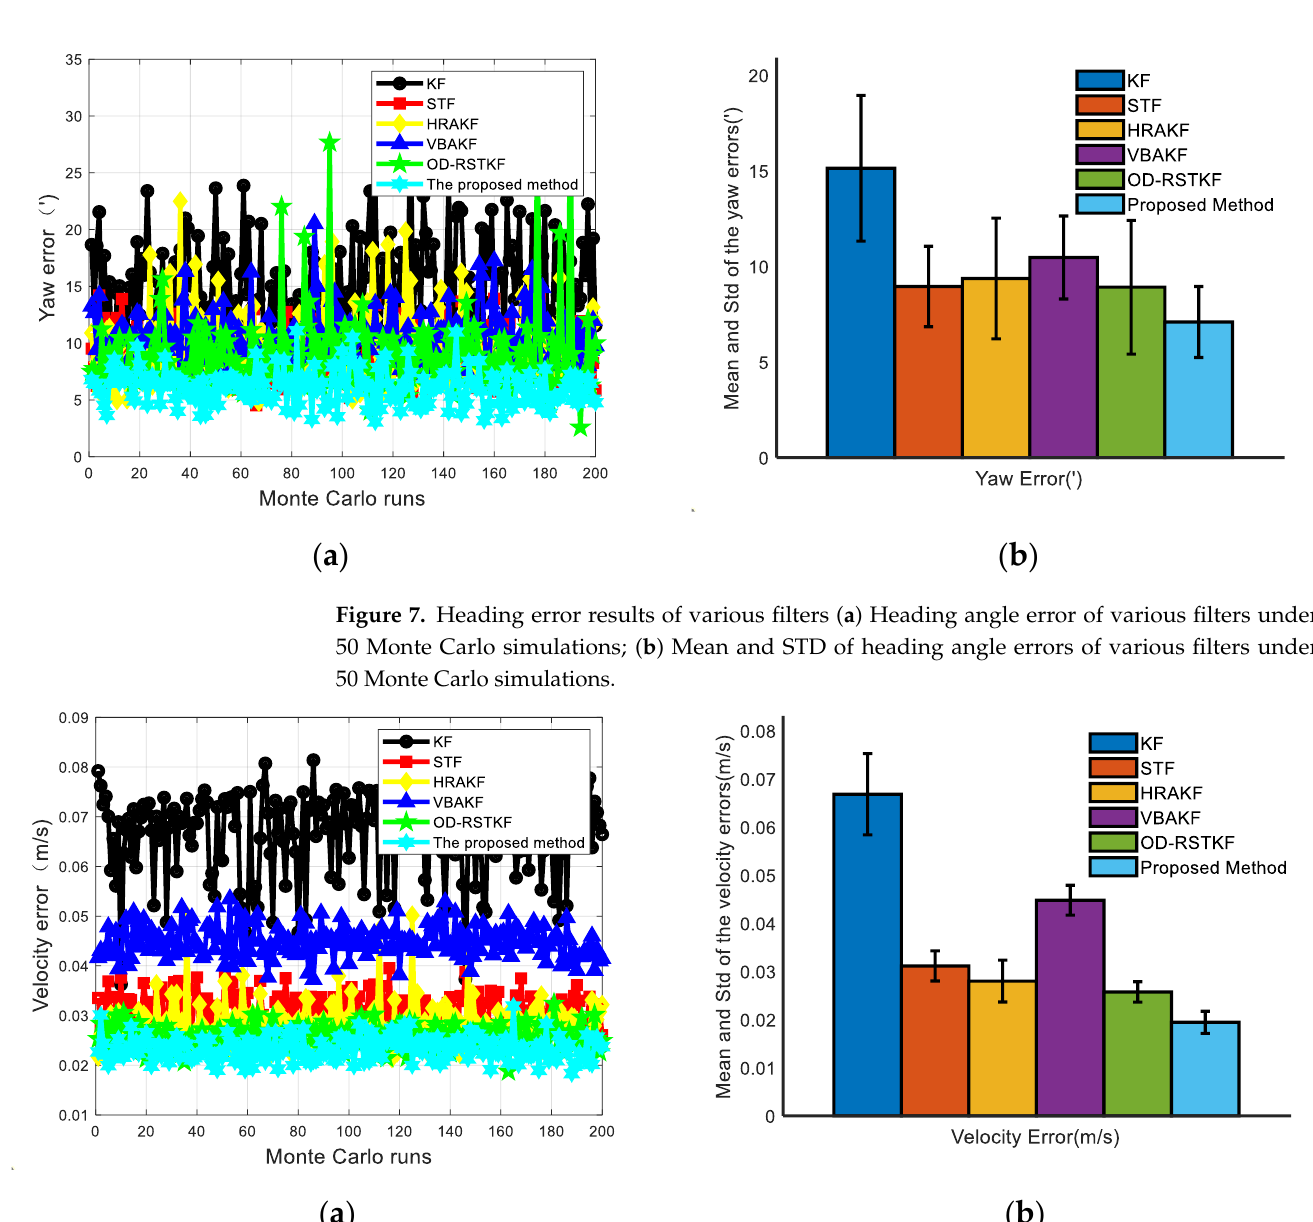
Figure 8. Velocity error results of various filters ( a ) Velocity angle error of various filters under 50 Monte Carlo simulations; ( b ) Mean and STD of velocity errors of various filters under 50 Monte Carlo simulations.